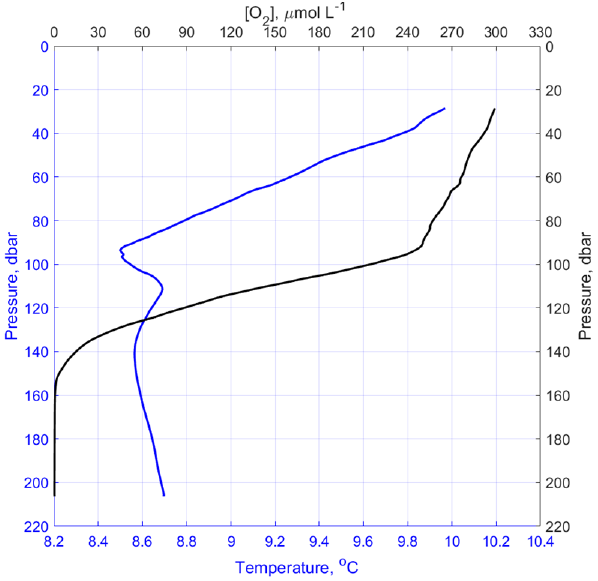
Figure 11. Mean profiles of water temperature and oxygen concen- tration during the period from 16:00UTC on 3 March 2016 until 07:00UTC on 6 March 2016. Note the minimum temperature in the new CIL at the depth range of